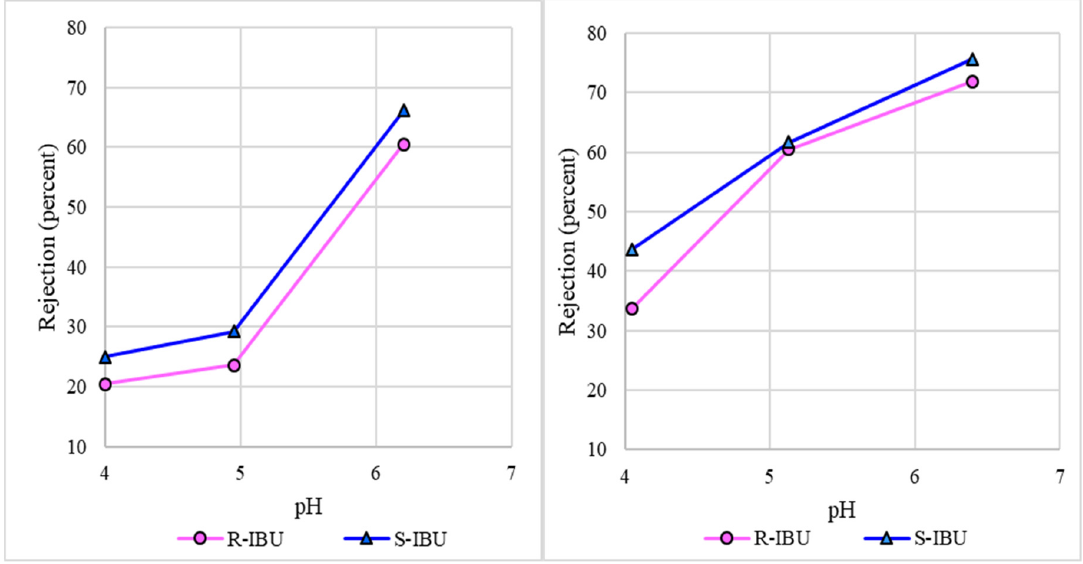
Figure 4. R- and S-IBU rejection as a function of feed water pH for NF270 membrane ( left ), TS40 membrane ( right ) (water flux 42.4 L/m 2 h, temperature 20 ± 1 °C).